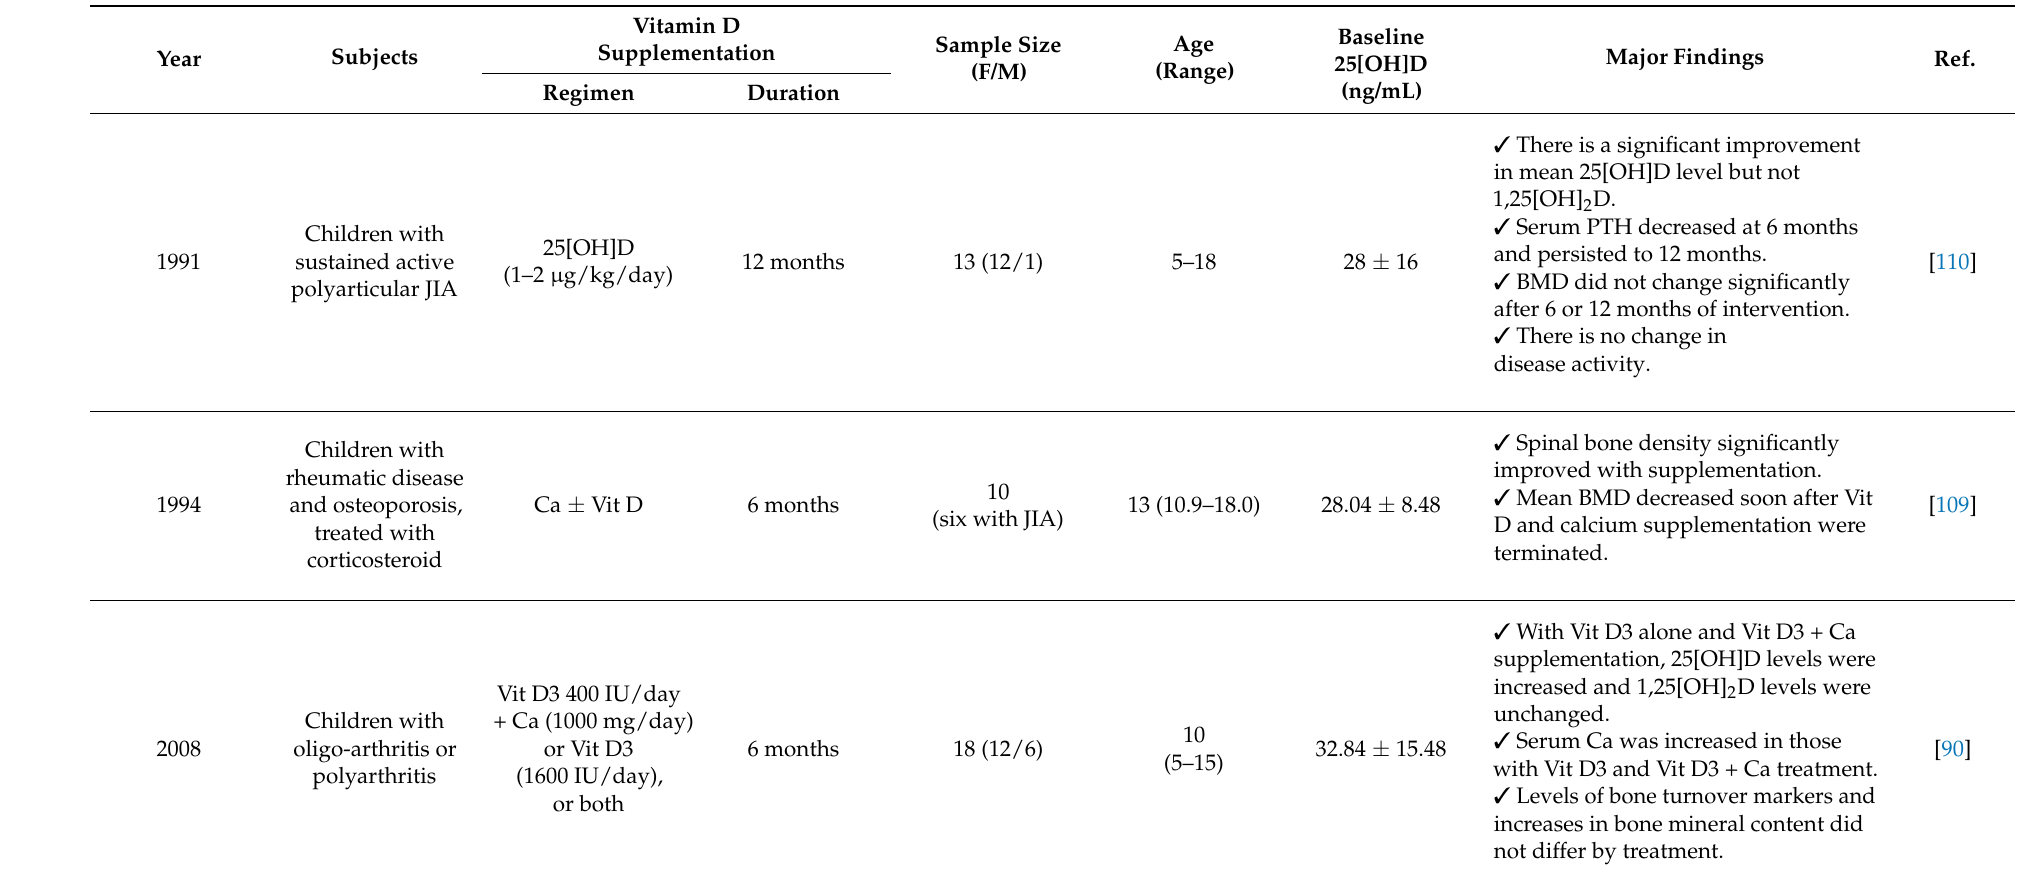
Table 1. Summary of current literature on prospective controlled vitamin D supplement